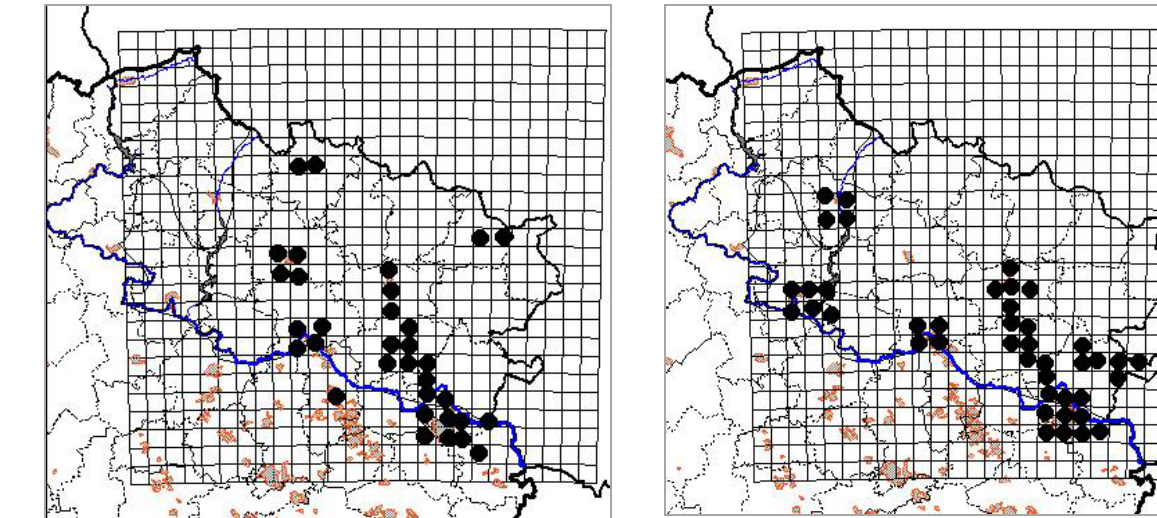
Fig. 21. The map of the distribution of Grindelia squarrosa (Pursh) Dunal in the Starobilsk grass-meadow steppe